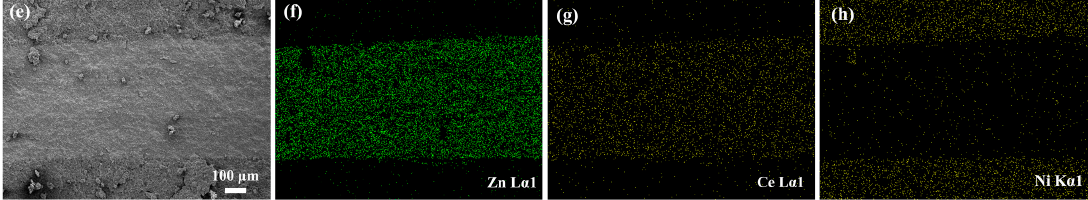
Figure 3. ( a ) SEM image and ( b ) detailed morphology of the membrane/cathode interface for ZnO-LCP cell after operation, and the corresponding elemental mappings for ( c ) Zn and ( d ) Ni; ( e ) Electron image of the cross-section for ZnO-LCP cell; and the corresponding elemental mappings for ( f ) Zn; ( g ) Ce and ( h ) Ni after operation.